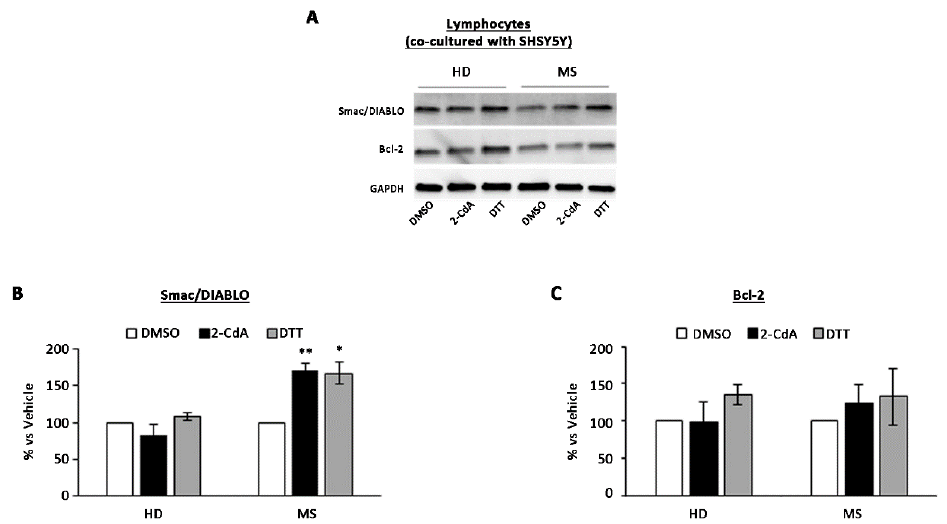
Figure 2. Effect of 2-CdA treatment on Smac/DIABLO and Bcl-2 protein expression in lymphocytes co-cultured with SH-SY5Y. ( A ) Representative Western blot of Smac/DIABLO and Bcl-2 levels performed on whole cell lysates. Bar graphs show quantification by densitometric analysis of Smac/DIABLO ( B ) and Bcl-2 ( C ) protein band normalized to GAPDH, used as loading control. Values (mean ± SEM of three independent experiments) are expressed as percentage of dimethyl sulfoxide (DMSO). Significance was calculated with Student’s t-test; * p < 0.05, ** p < 0.005 vs. DMSO. DTT, dithiothreitol. The most interesting aspect is that no differences were observed in terms of protein levels in SH- SY5Y cells exposed to 2-CdA in all the three conditions of culture: SH-SY5Y single-cultured and SH- SY5Y co-cultured with HD and MS lymphocytes (Figure 3). These data confirm that 2-CdA could increase apoptotic condition in MS cells and does not affect neuronal cell apoptotic state because the apoptotic state induced by 2-CdA on lymphocytes does not occur in SH-SY5Y cells (Figure 3). Figure 3. Effect of 2-CdA treatment on Smac/DIABLO and Bcl-2 protein expression in SH-SY5Y single- cultured and co-cultured with HD and MS lymphocytes. ( A ) Representative Western blot of Smac/DIABLO and Bcl-2 levels performed on whole cell lysates. Bar graphs show quantification by